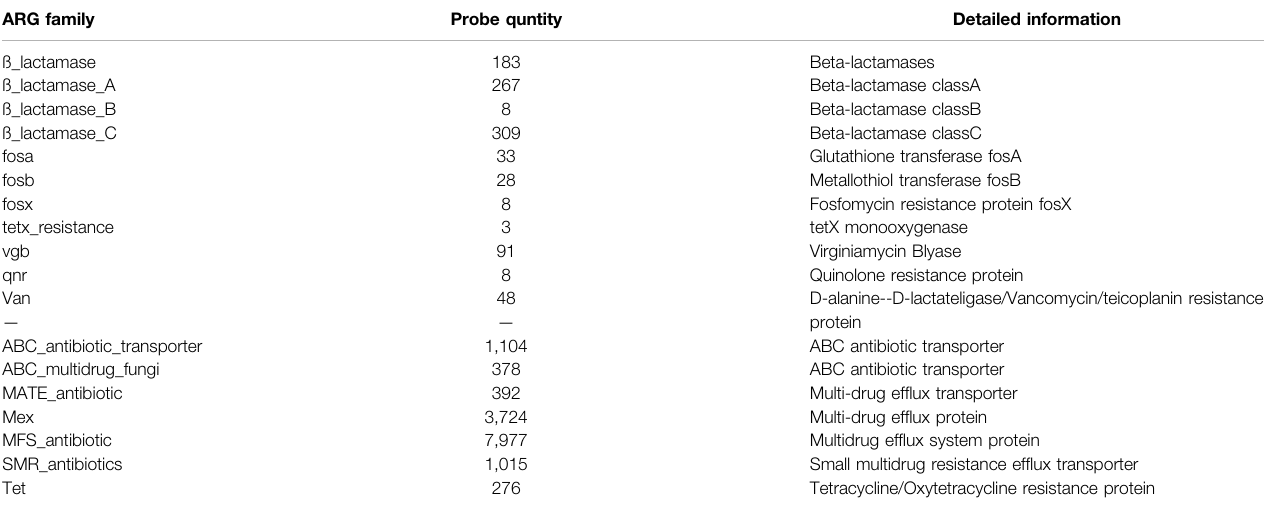
TABLE 2 | The detail of ARG families on GeoChip 5 ARG